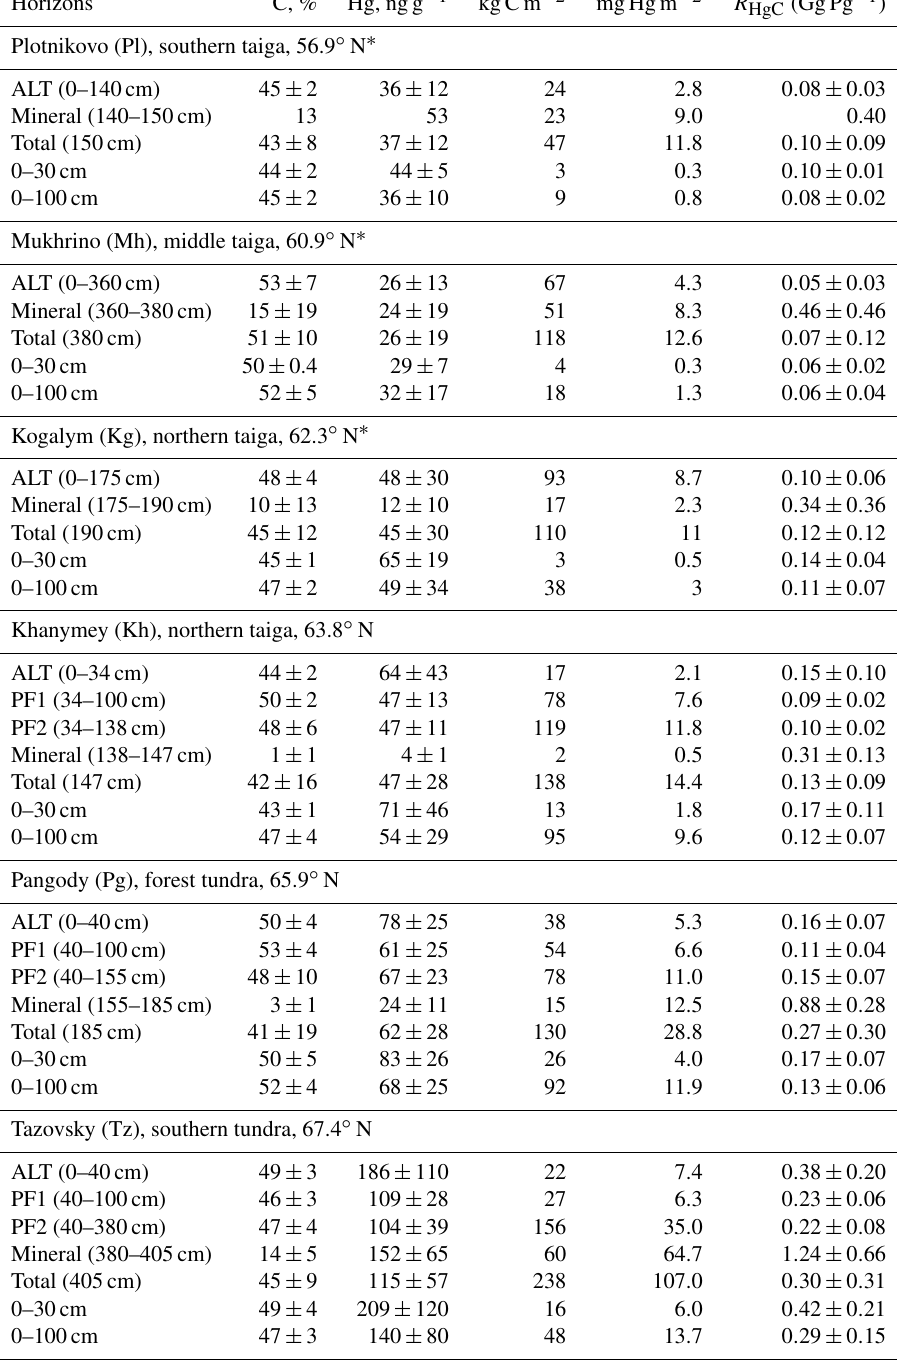
Table 1. Mean ( ± SD) concentrations and stocks of C and Hg in six studied sites in the Western Siberian Lowland (WSL) peat bogs. Horizons C, % Hg, ngg − 1 kgCm − 2 mgHgm − 2 R HgC (GgPg − 1 ) Plotnikovo (Pl), southern taiga, 56.9 ◦ N ∗